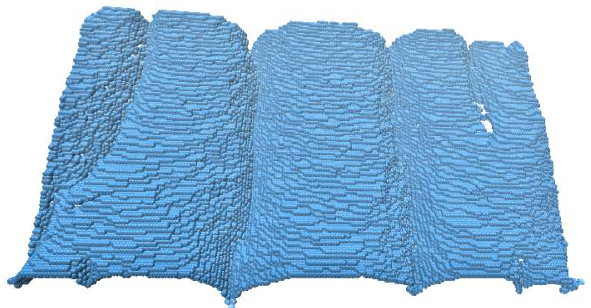
Figure 2. Meanders, c 0 = 0.01, P iES = 1, P dES = 0, p w = 1, l 0 = 5, n DS = 10. System size 200 × 200.